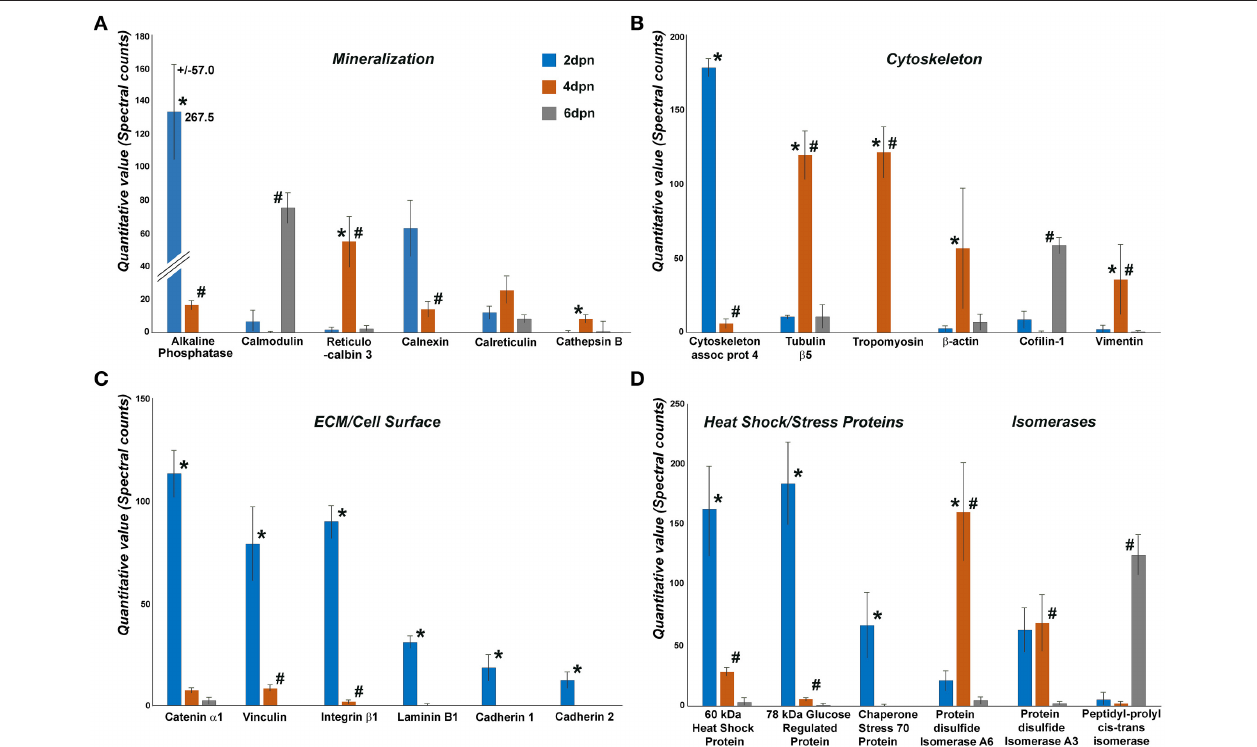
FIGURE 4 | Comparison between spectral counts of individual proteins identified during postnatal mouse molar enamel development (days 2, 4, and 6 dpn)(99% probability, 2 peptide minimum). Proteins were grouped into four categories: (A) mineralization, (B) cytoskeleton, (C) extracellular matrix/cell surface, and (D) other. Six proteins with highest quantitative values in each group were chosen for display and further analysis. Orbitrap mass spectrometry is inherently biased to exclude hydrophobic proteins (Carroll et al., 2007; Griffin and Schnitzer, 2011), promoting a methodological focus on hydrophilic proteins at the expense of the hydrophobic proteins that occupy the majority of the developing enamel matrix. Spectral counts of 2 dpn (blue), 4 dpn (yellow), and 6 dpn (gray) enamel matrix were distinguished by color coding, and levels of significance were marked as * p < 0.05, for comparisons between 2 and 4 dpn data, and # p < 0.05, for comparisons between 4 and 6 dpn